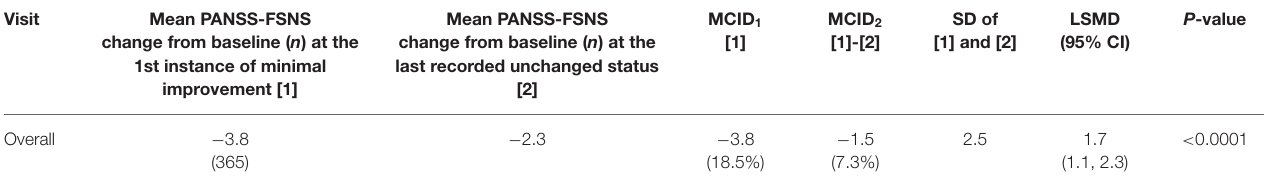
TABLE 1 | Anchor based calculations of the MCID. Visit Mean PANSS-FSNS change from baseline ( n ) at the